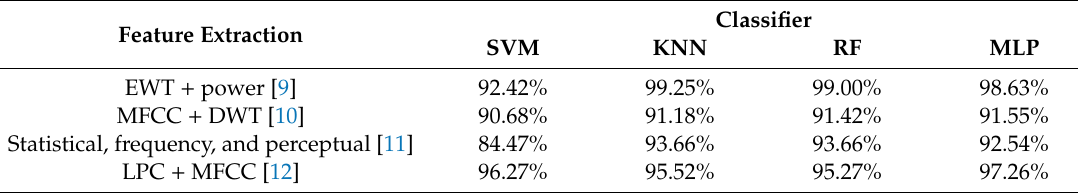
Table 5. Accuracy results of the methods proposed in [9–12], taken from article [9].